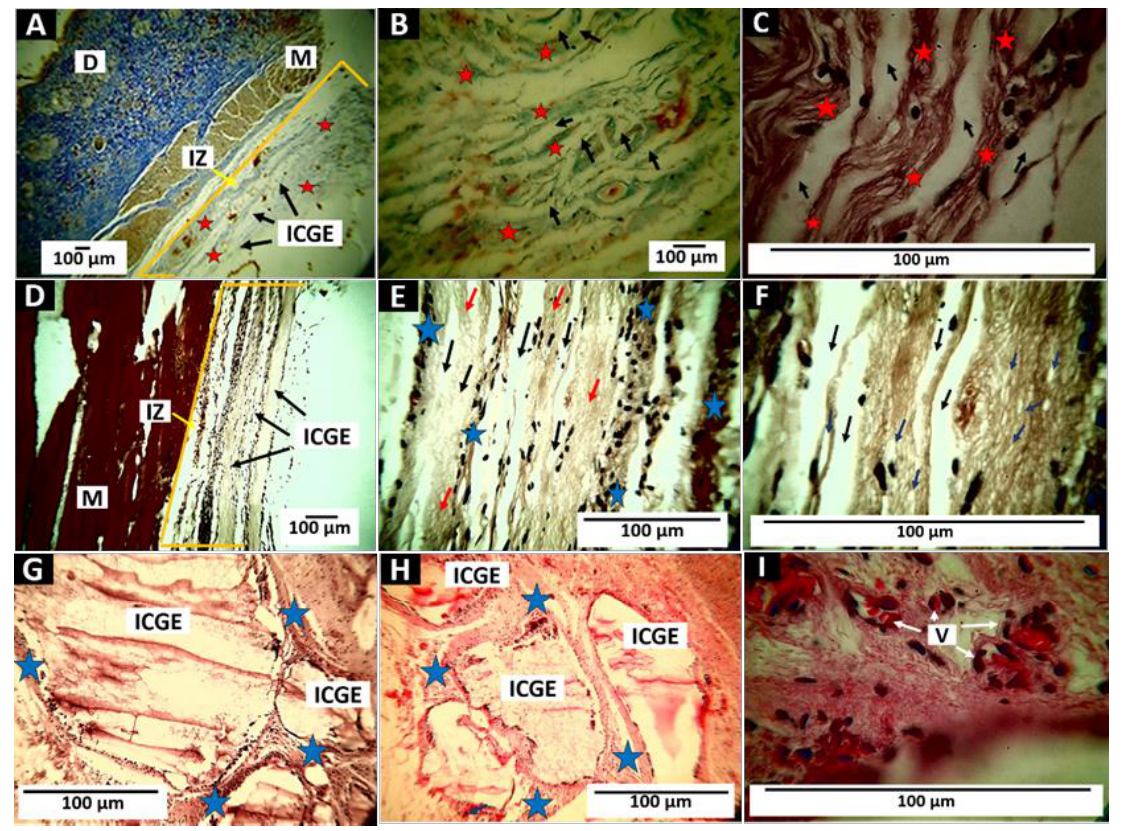
Figure 13. Subdermal implantation of F3 (InterCollagen Guide). ( A ) Image at 4×. MT technique. ( B ) 10×. MT technique. ( C ) 100×. H-E technique. ( D ) 10×. H-E technique. ( E ) 40×. H-E technique. ( F ) 100×. H-E technique. ( G ) 40× H-E technique. ( H ) 40×. H-E technique. ( I ) 100×. H-E technique. D: Dermis. M: Muscle. IZ: Implantation zone. IOC: InterOss Collagen. Black arrows: ICG fragments. Red arrows: Area of material ’ s reabsorption. Blue arrows: pieces of the material in the resorption zone. Stars: a fibrous capsule that surrounds the material. V: blood vessels. subfigure ( A ) – ( C ): Material implanted at 30 days. ( D ) – ( F ): Material implanted at 60 days. ( G ) – ( I ) Implanted at 90 days.